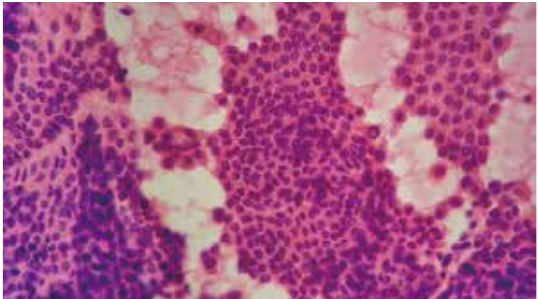
Figure 4 FNAC of the left thyroid nodule. Microscopically, the thyroid follicular epitheliums were closely packed, overlapped, and arranged in papillary shape, with distinctive nuclear groove and pseudo-inclusion bodies visible (original magnification ×